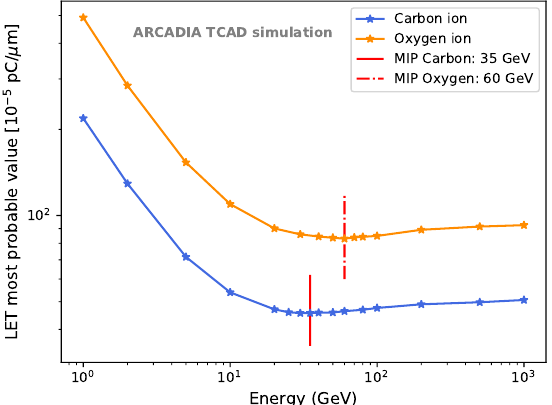
Figure 11. Dependence of the LET on the energy of carbon ions (C 12 + , blue) and oxygen ions (O 16 + , orange) incident on 50 µ m thick silicon. The LET values were evaluated through Geant4 simulations. The red vertical lines indicate the minimum ionization energies for the two particle